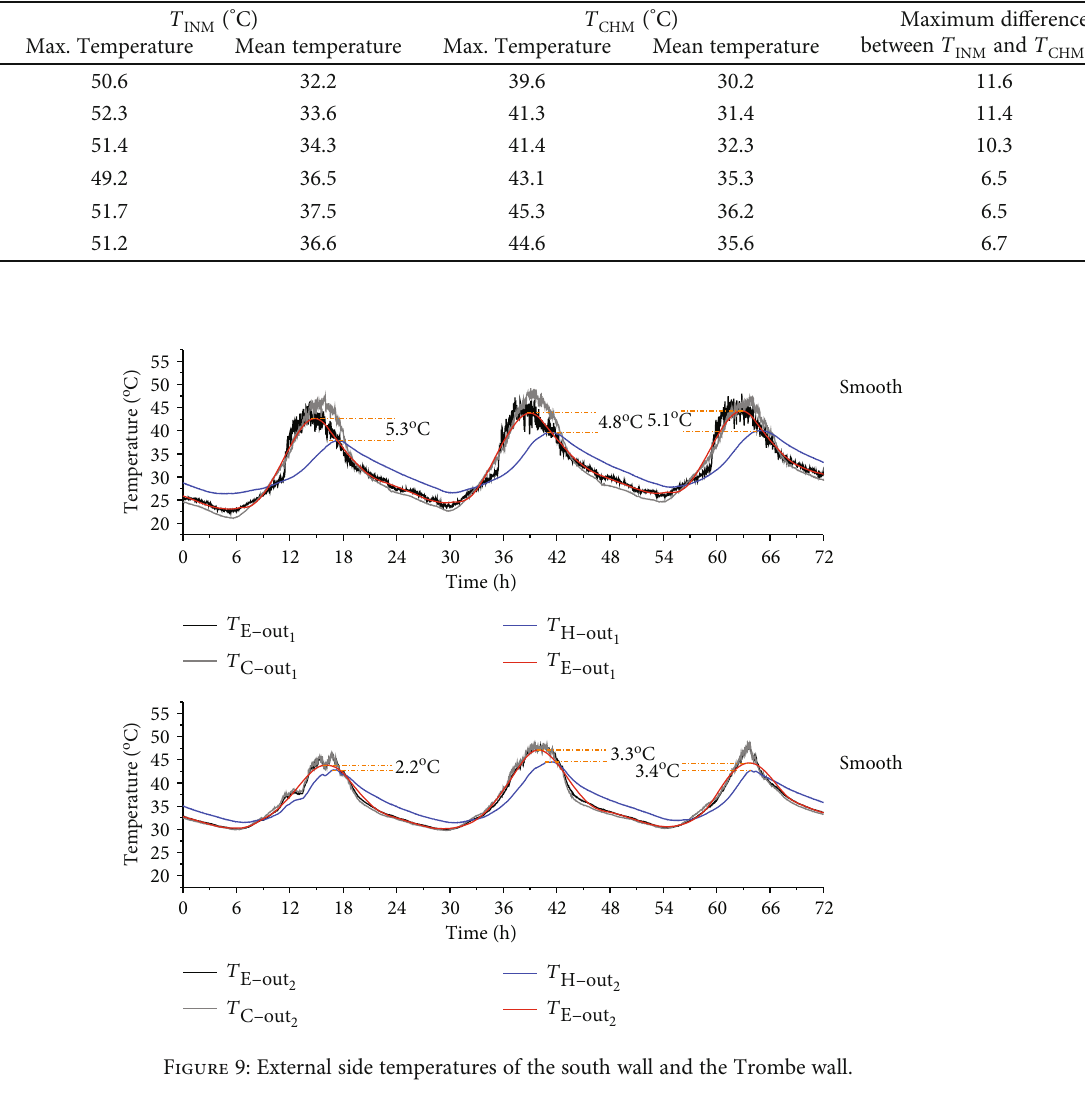
° C) Maximum di ff erence CHM ( between T INM and T CHM ( ° C)Max. Temperature Mean temperature Max. Temperature Mean temperature